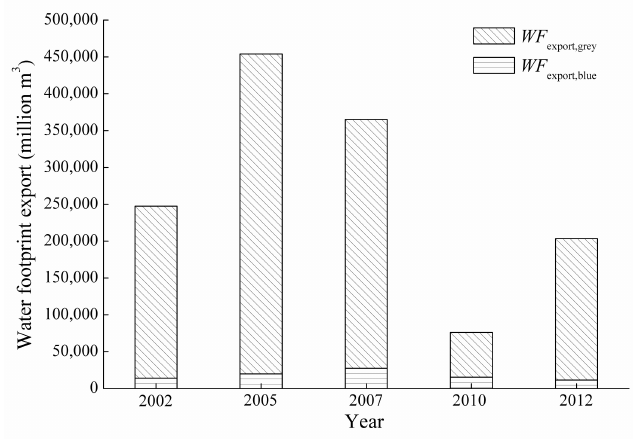
Figure 8. Compositions of water footprint export of China from 2002 to